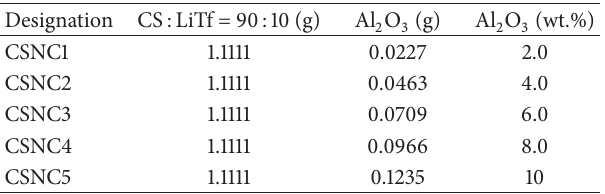
Table 1: Compositionof ( 1−𝑥 )(0.9CS:0.1LiTf)- 𝑥 Al 2 O 3 ( 0.02 ≤ 𝑥 ≤ 0.1 )